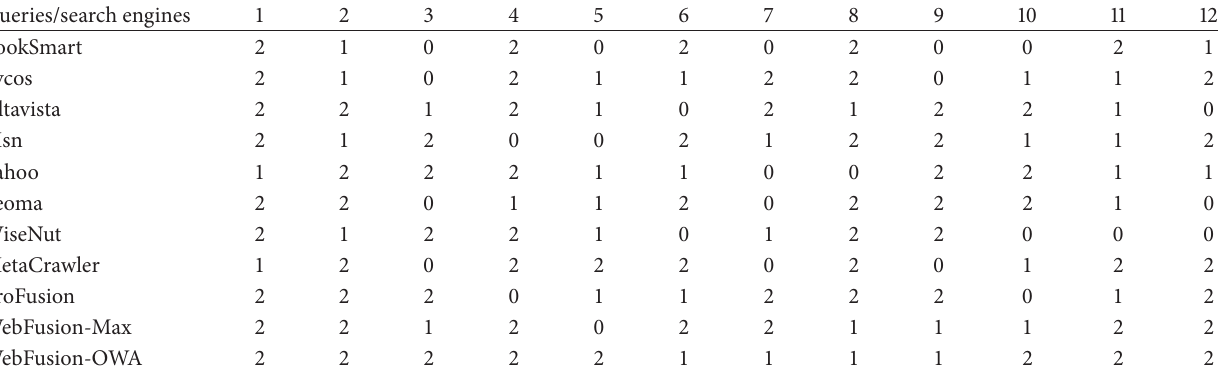
Table 3: Matrix of judgment for sample queries.